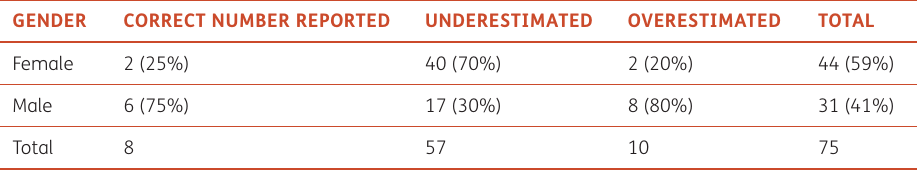
Table 3 Reporting of reciprocal relationships amongst survey respondents (number of respondents and percentage of column total in